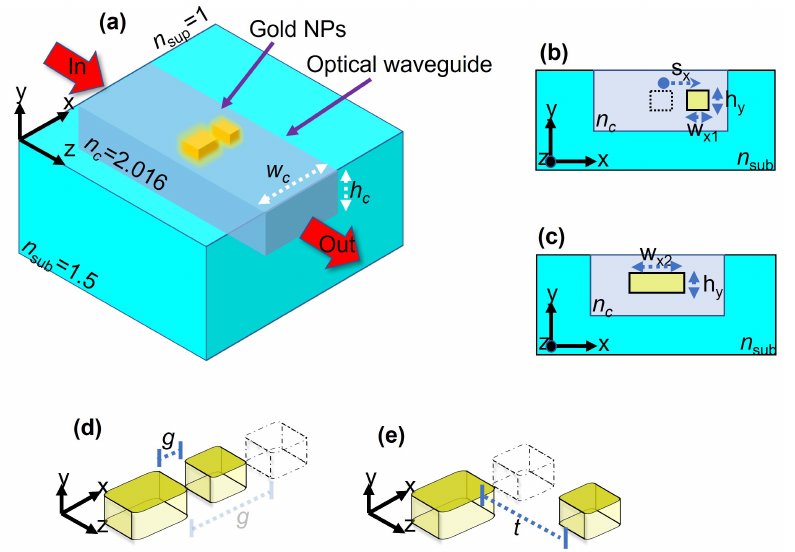
Figure 1. ( a ) Schematic of two gold NPs embedded in the core of a Si 3 N 4 waveguide. ( b ) Short NP laterally displaced by a distance s x from the center of the core to the center of the NP. ( c ) Long NP integrated at the center of the waveguide. ( d ) Two NPs laterally separated by a gap g along the x axis. ( e ) Two NPs longitudinally separated by a distance t along the z